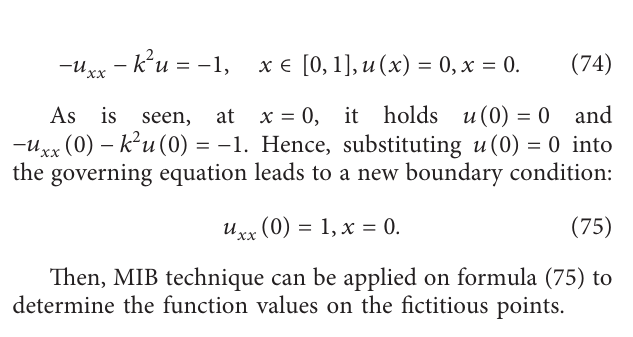
, (c) the second step to determine f 1